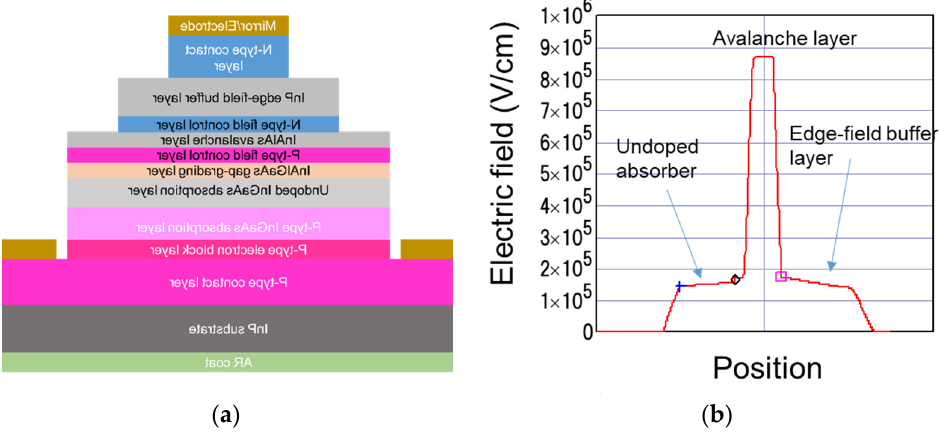
Figure 7. ( a ) Schematic cross-section of our inverted p-down avalanche photodiodes (APD) and ( b ) its electric-field profile.